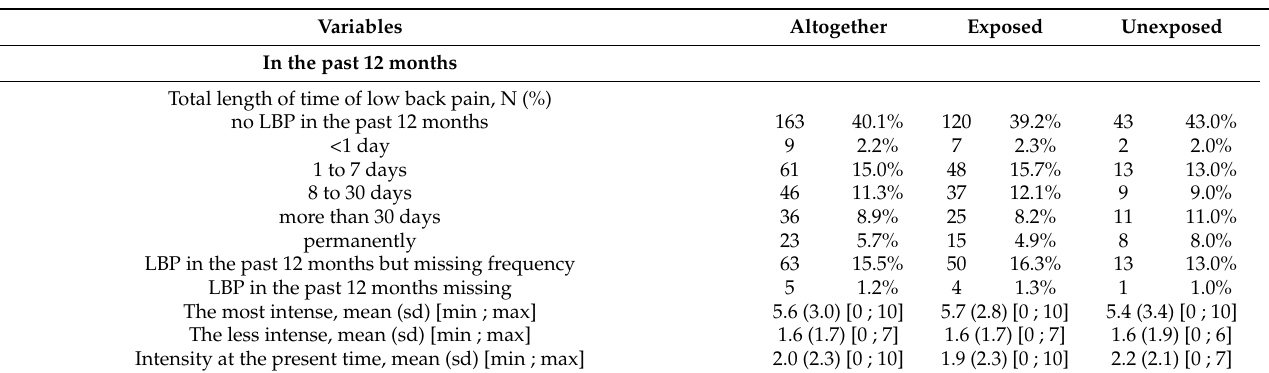
Table 3. The 14-item questionnaire to assess low back pain within two time frames (last 12 months and recently) in subjects exposed and unexposed to driving. Except for the total length of time of low back pain in the past 12 months, the percentages are calculated excluding the 163 postal workers declaring no low back pain in the past 12 months in the Nordic questionnaire. Abbreviations: N: number of subjects; m(sd) [min; max]: mean (standard deviation) [minimum and maximum values of